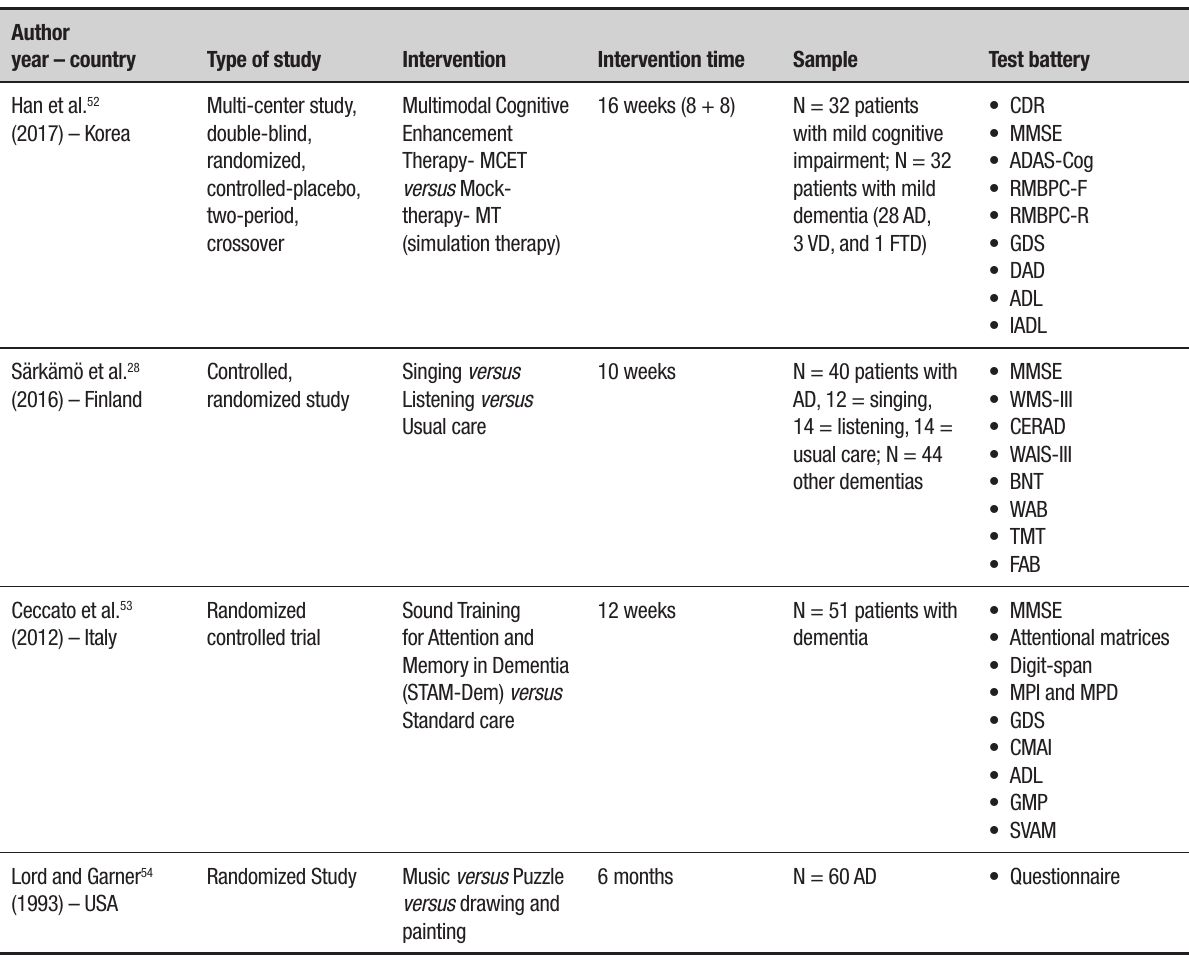
Table 2. Characteristics of the included